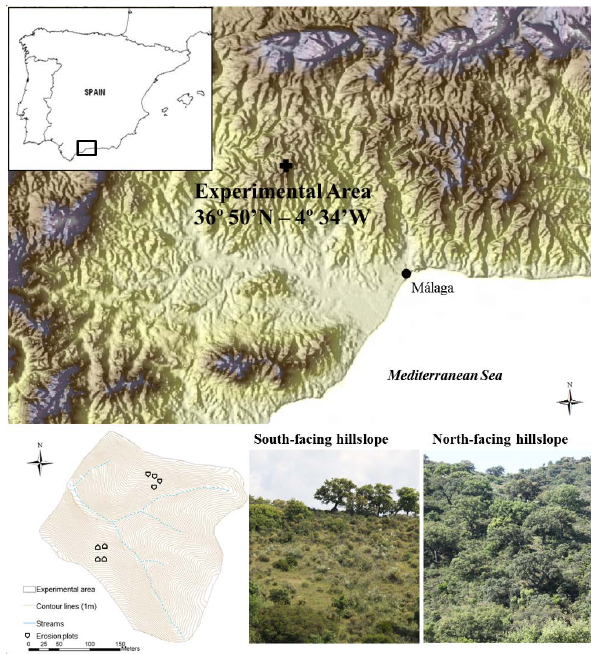
Fig. 1. Location of the experimental area and general view of both north- and south-facing